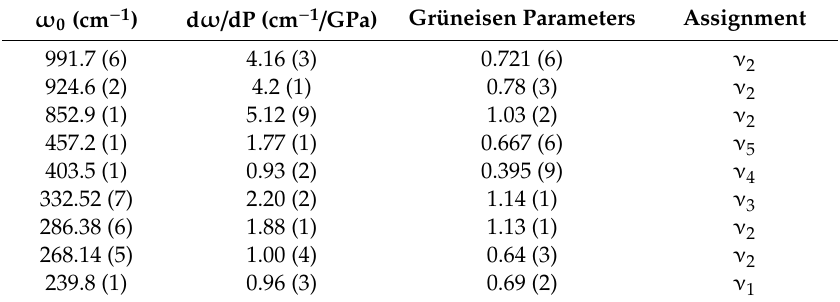
Table 2. Mode shifts, derivative of Raman shift to pressure, and mode Grüneisen parameter of topaz.